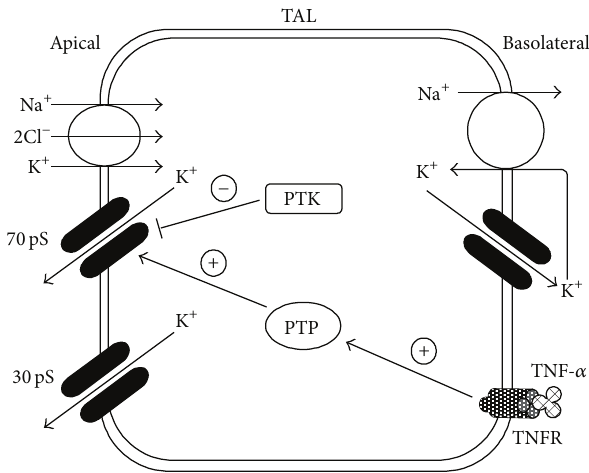
Figure 3: Illustration of the acute effect of TNF- 𝛼 on the 70 pS K +